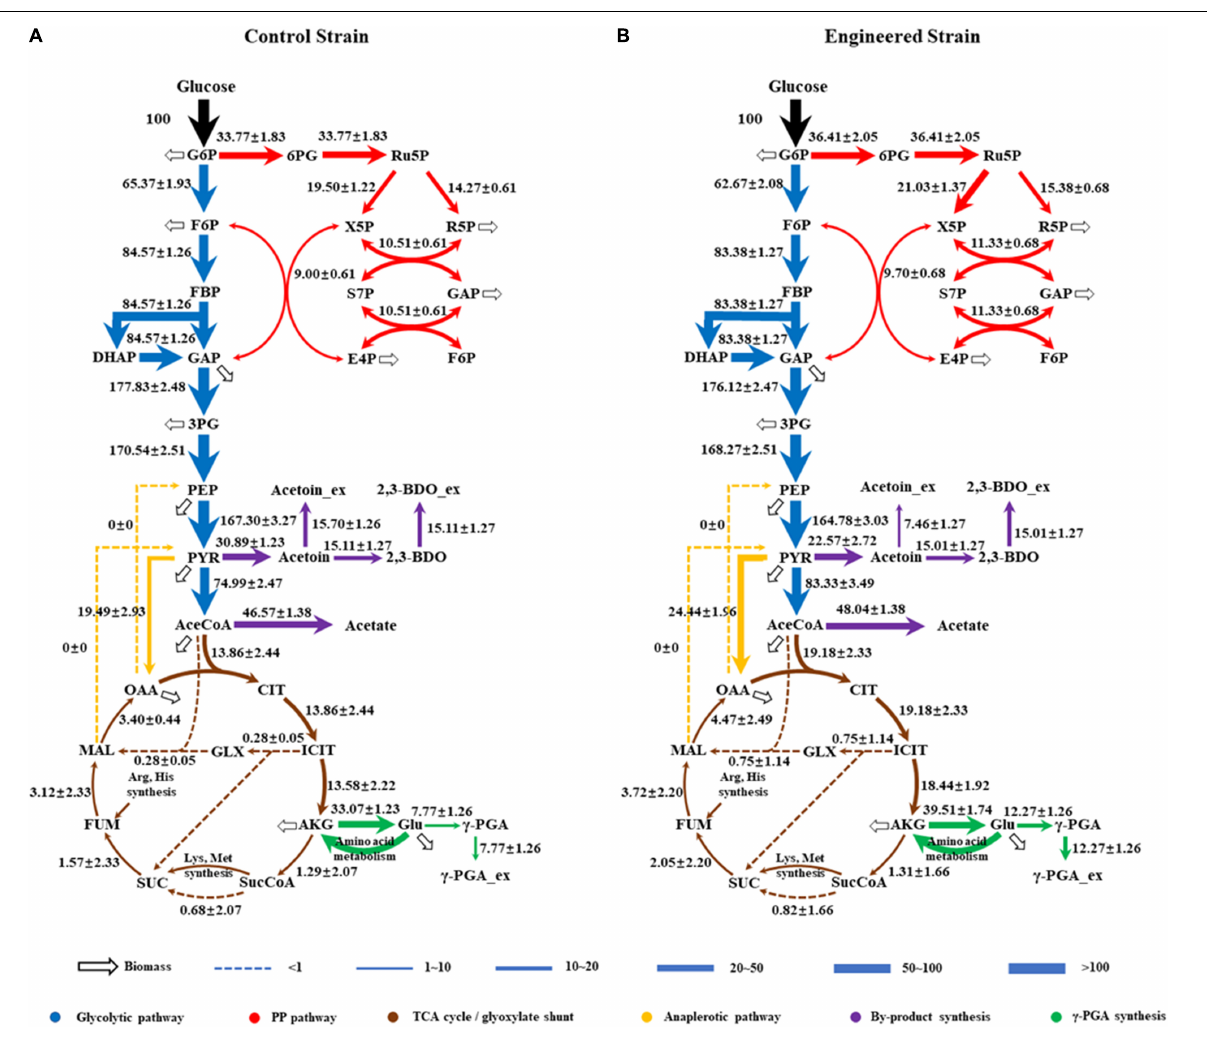
Frontiers in Microbiology |